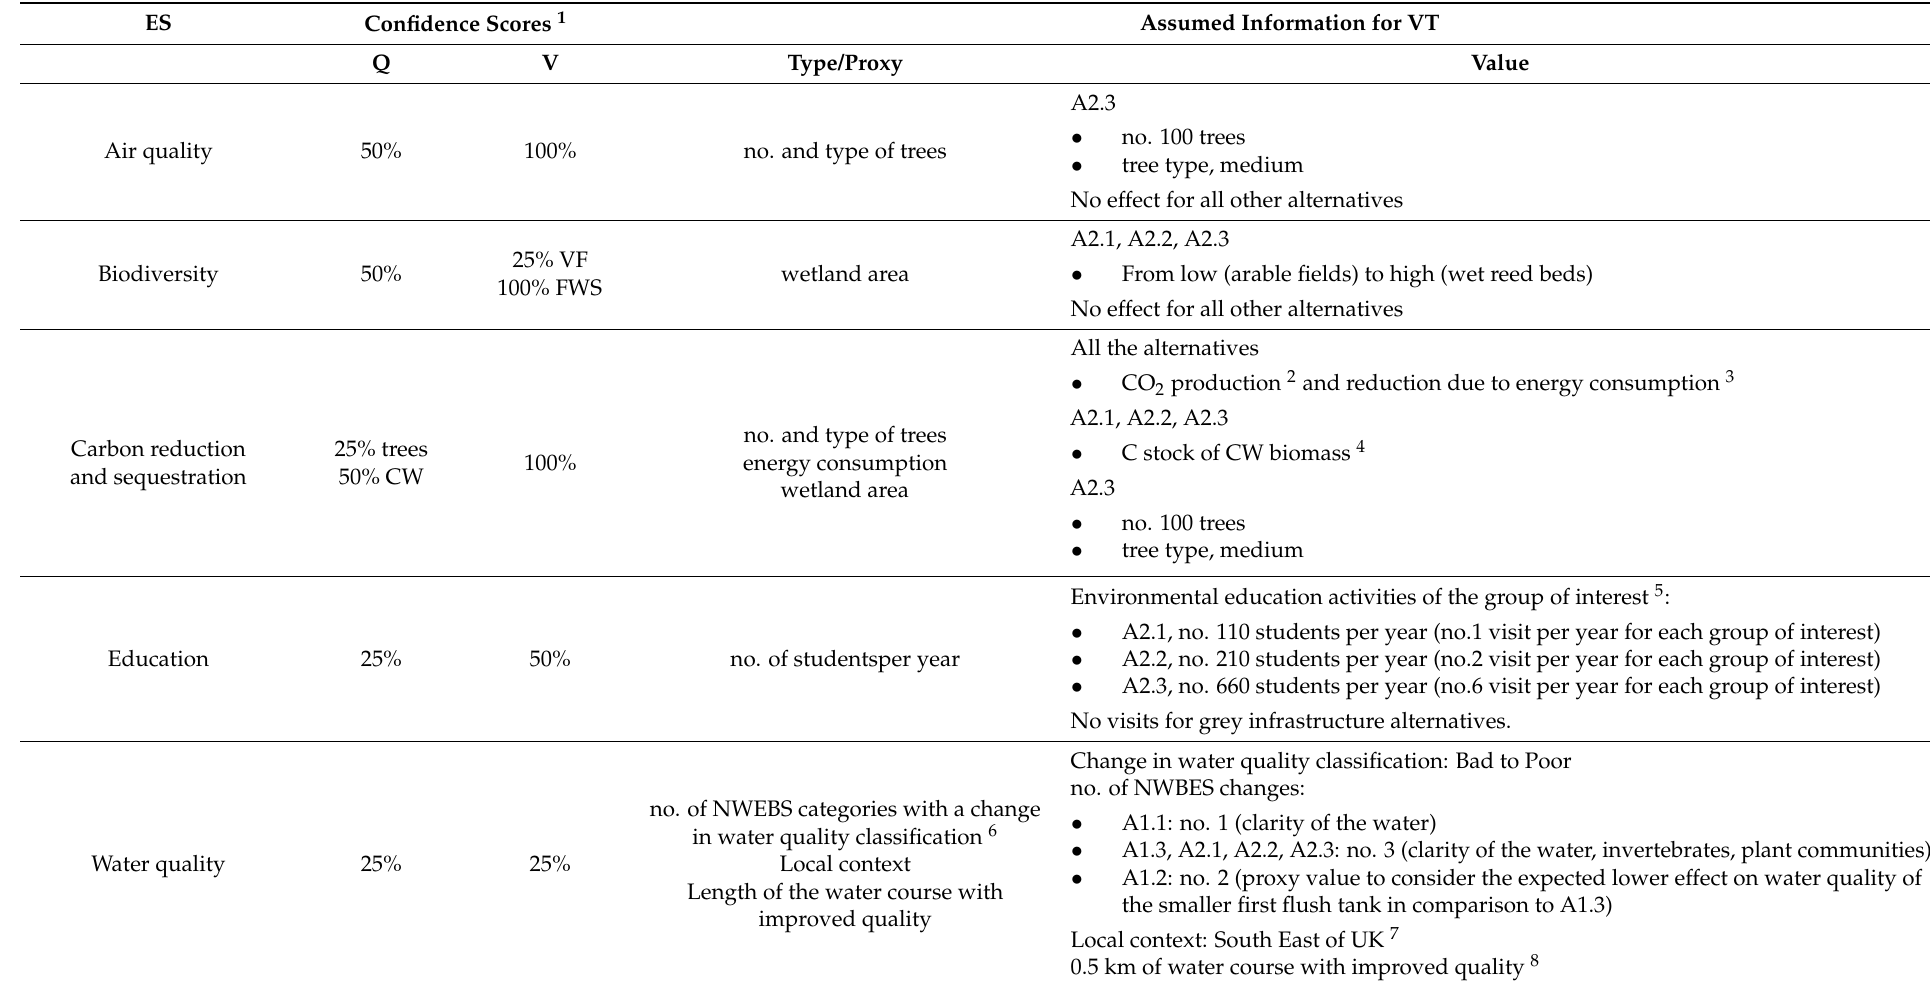
Table 2. Assumptions used in B£ST for the value transfer (VT) of ecosystem services (ESs) for the different MCA alternatives, including quantity (Q) and valuation in £ (V) confidence scores. A1.1: primary treatment only (primary only). A1.2: first flush tank, minimum size (FFT—min). A1.3: first flush tank, maximum (FFT—max). A2.1: vertical subsurface flow